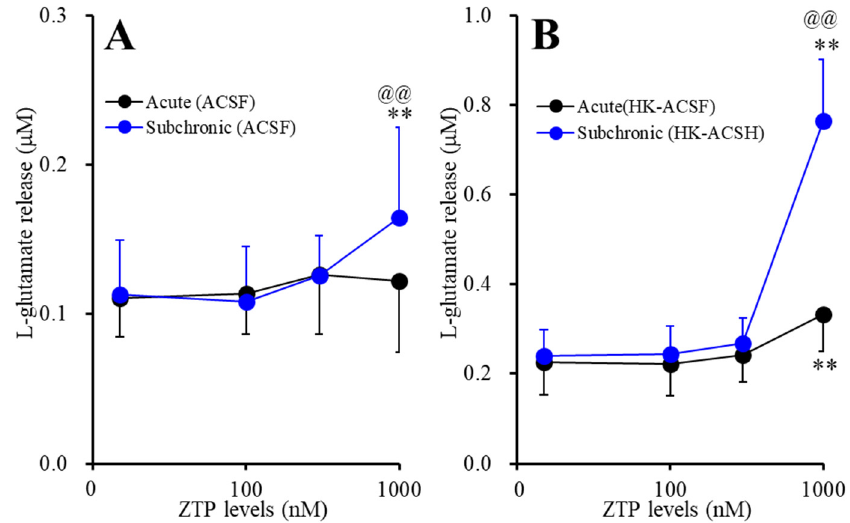
Figure 1. Concentration-dependent effects of the acute (black circles) and subchronic (blue circles) administrations of zotepine (ZTP: 100, 300 and 1000 nM) on the ( A ) basal and the ( B ) high (100 mM) K + with Ca 2+ free artificial cerebrospinal fluid (HK-ACSF)-evoked astroglial L-glutamate releases. Ordinate: mean ± SD (n = 6) of the astroglial L-glutamate release ( μ M), and abscissa: concentration of ZTP (nM). * p < 0.05, ** p < 0.01: relative to ZTP-free, @ p < 0.05, @@ p < 0.01: relative to acute administration by multivariate analysis of variance (MANOVA) with Tukey’s (wholly significant difference) post hoc test.